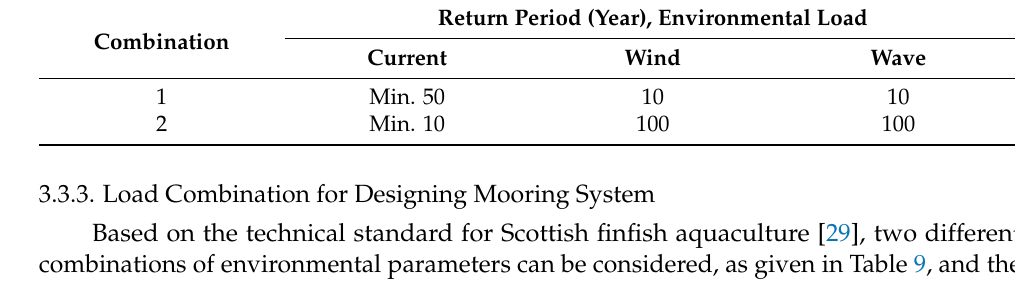
Table 8. DNV’s combinations of environmental loads for fish net pens.